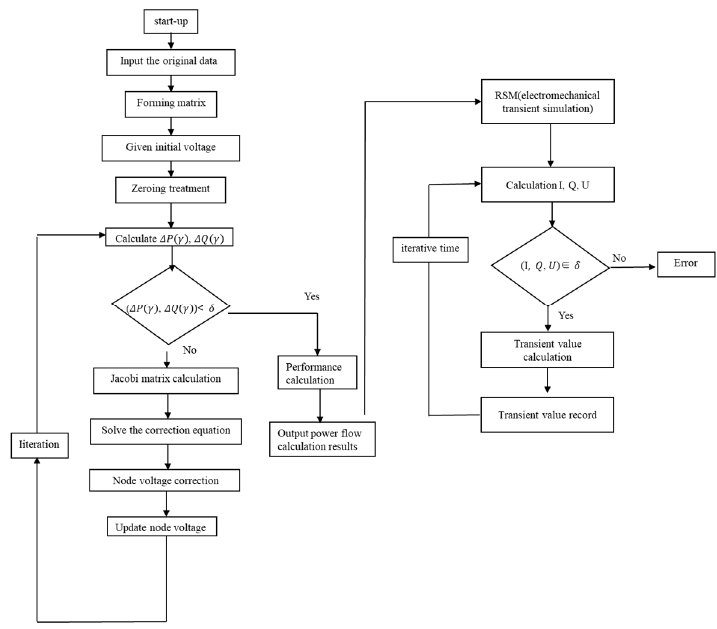
Figure 3. Flow chart of calculation method.